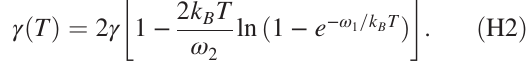
FIG. 23. Partial integral of the loss function as a function of FIG. 22. Relative change of the integral of the loss function temperature obtained by using the scattering rate in a Drude between 0 and 2.5 eV with respect to room temperature of sample model of Norman et al. Bi2212-91-OpD. Black line: The “ q ¼ 0 ” result, same as in the lower right panel of Fig. 11. Red, blue, green, and orange curves are the finite-momentum extrapolation to finite q 0 ¼ 0 . 31 Å − 1 , using different extrapolation schemes. Red curve: 2D bilayer expression, Eq. (14), with n ¼ 2 , and d ¼ 3 . 2 Å. Blue curve: 2D monolayer expression, Eq. (G11). Green curve: Layered electron ϵ 4 . 5 . Orange: gas (LEG) expression, Eq. (G9), with ϵ c ¼ sc ¼ T Þ described by Eq. (G1). The LEG expression, Eq. (G9), with ϵ c ð overlap of orange and green curves indicates that the c -axis loss function has negligible influence on the temperature dependence of the Coulomb energy. The overlap of red, blue, and green curves implies that the extrapolation has negligible dependence on the type of extrapolation scheme chosen. While the black curve is the expression for the “ true ” Coulomb energy that one would get by simply multiplying the optically measured loss function by the area of the first Brillouin zone, the colored curves are expressions for the “ MIR Coulomb energy ” as discussed in Sec. IVA. The fact that the colored curves are a substantial fraction of the black one — rather than being related to it approximately by the ratio of the disk q < 0 . 31 A − 1 to that of the first Brillouin zone — is largely attributable to the replacement of E by E mir ; see Eq. (F17) for the 3D case and Eq. (G11) for the C C 2D case.